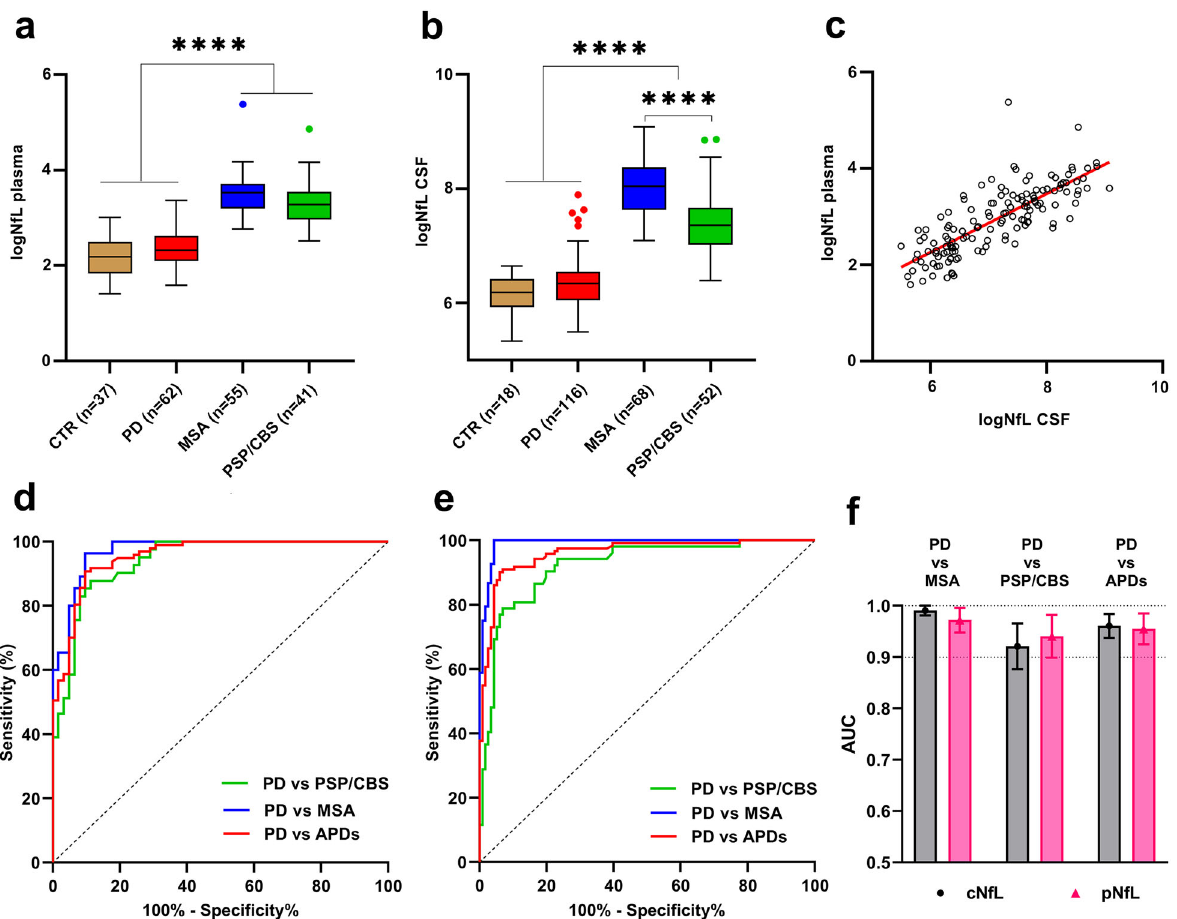
Fig. 1 Plasma and CSF NfL values and ROC analysis to discriminate between PD and APDs. Boxplots illustrate natural-log transformed levels of a pNfL and b cNfL in the main diagnostic groups; **** p < 0.0001. Bounds of box plots show the range from the 25th to the 75th percentiles and the central line indicate the median value of the distribution; whiskers identify the Tukey ’ s range and symbols indicate the outliers according to the Tukey test. c Correlation between natural-log transformed pNfL and cNfL levels. ROC curves of d pNfL and e cNfL levels to distinguish PD from MSA, PSP/CBS, or the whole APDs group with f related actual AUC values (error bars indicate the 95%